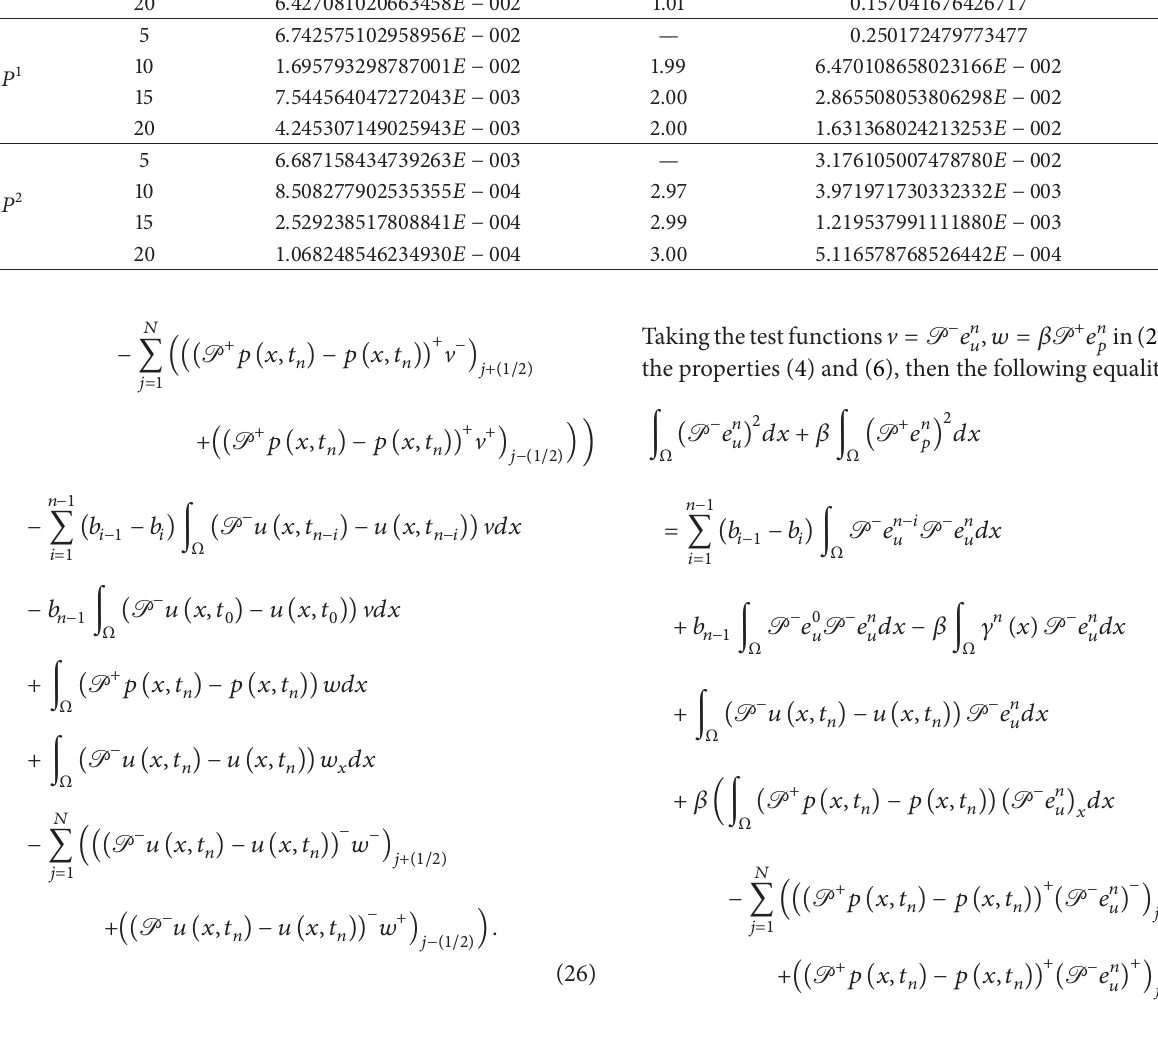
6.742575102958956𝐸 − 002 — 0.250172479773477